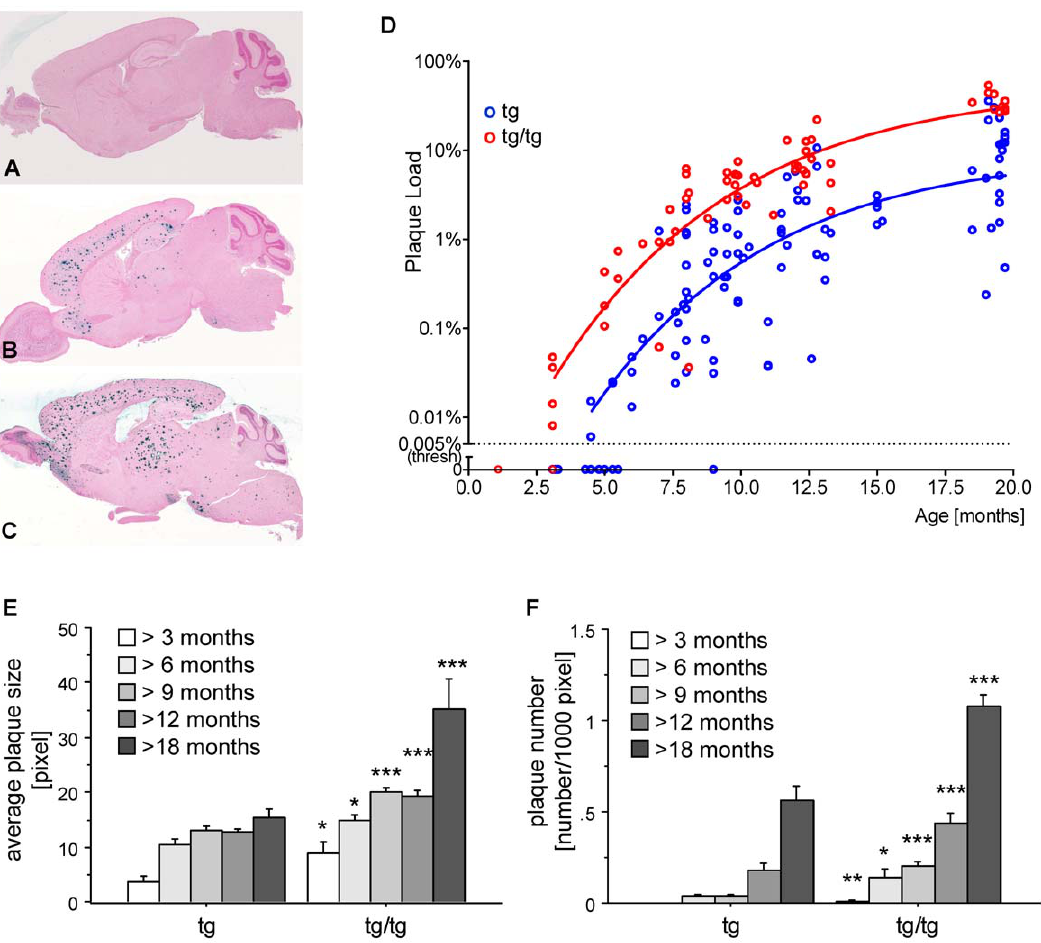
Figure 2. Onset and development of plaques in ARTE10 mice. A–C , Digital micrographs of parasagittal forebrain sections from homozygous transgenic mice immunohistochemically stained for b -amyloid plaques ( dark blue-green ) at 3 (A), 8 (B), and 13 months of age (C). D–F Plaques are quantified using Acapella TM plaque recognition software in regions of interest on stained mouse brain sections. D , Plaque load is expressed as percentage of plaque area per total area of neocortex and hippocampus across ages in homozygous ( red ) versus hemizygous mice ( blue ). Each symbol represents one animal. The average size (E) and number of plaques per area (F) progressively increase with age in hemizygous (tg) and homozygous (tg/ tg) ARTE10 mice. Data are expressed as means + SEM; * p , 0.05, ** p , 0.01, *** p , 0.0005, tg versus tg/tg at the respective age (unpaired